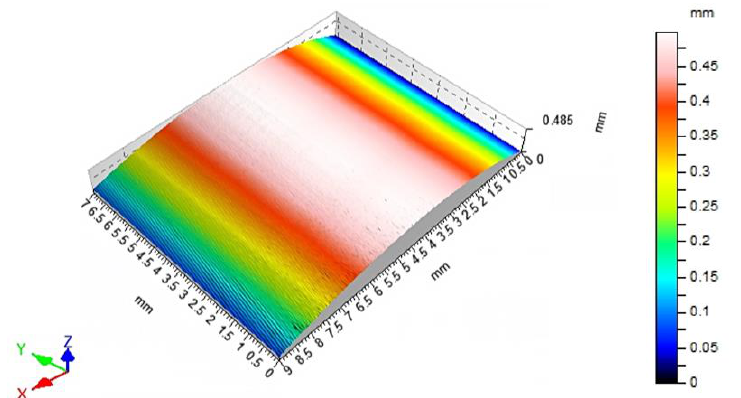
Figure 11. A stereometric distribution of the machined tooth—sample 4, machined with a feed speed of V f = 1800 mm/min.